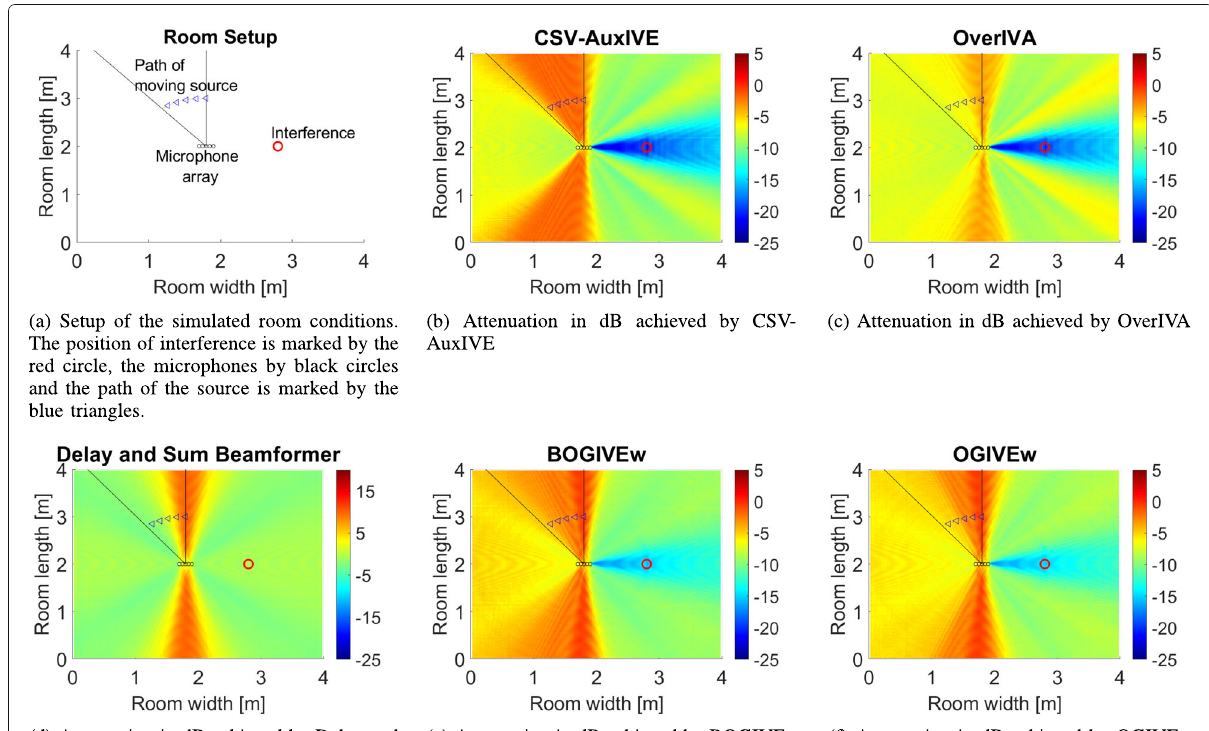
Fig. 2 Setup of the simulated room and the attenuation in dB achieved by DOA, OGIVE w , BOGIVE w , OverIVA, and CSV-AuxIVE from the experiment in Section 4.1